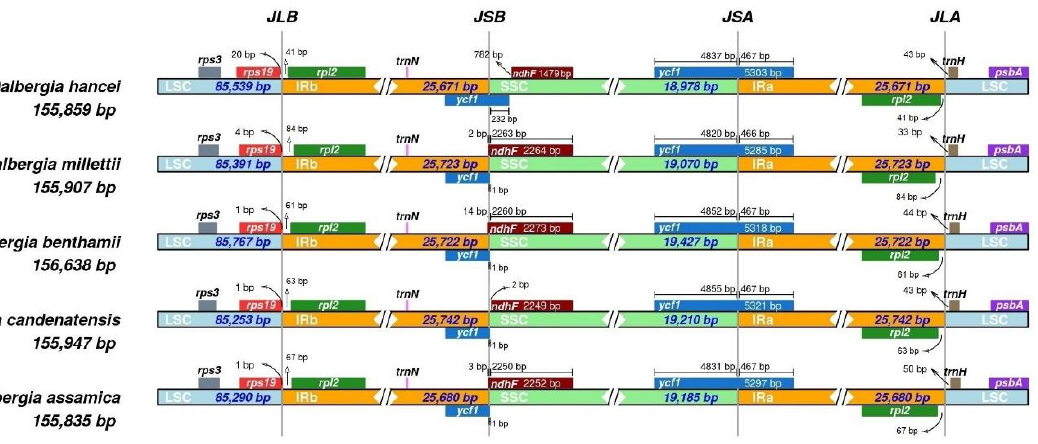
Figure 3. Comparison of the junction regions of the cp genomes of the five Dalbergia species. (JLB: junction between LSC and IRB; JSB: junction between SSC and IRB; JSA: junction between SSC and IRA; JLA: junction between LSC and IRA).